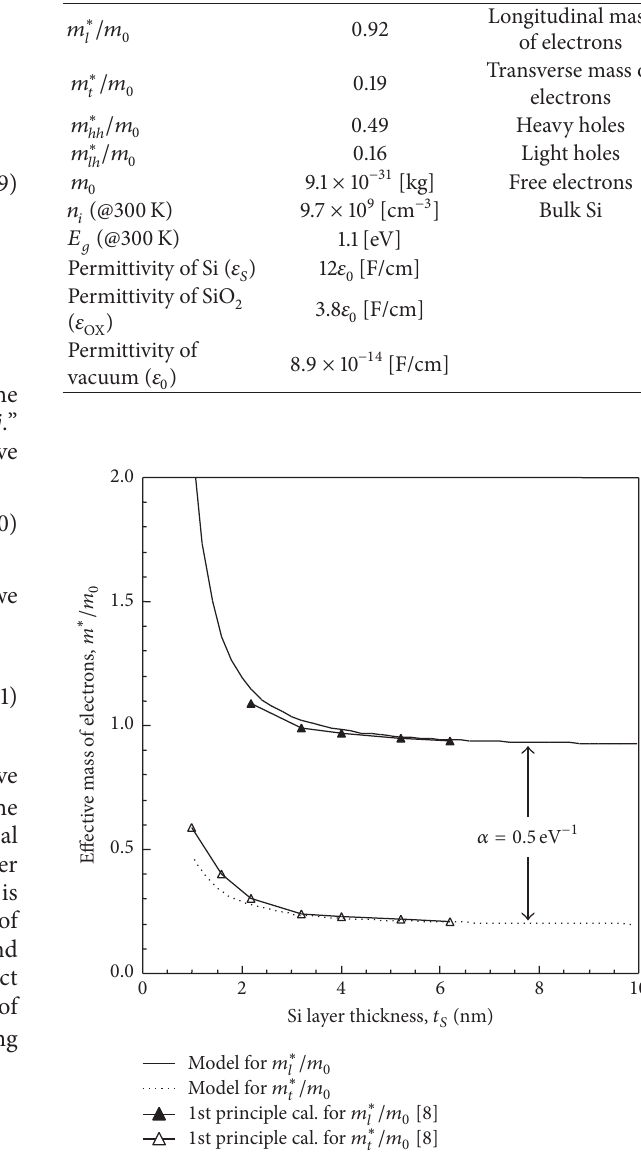
Figure1:Calculatedeffectivemassvaluesofelectronsoccupyingthe ground state as a function of semiconductor layer thickness [11]. It is assumed that 𝛼 = 0.5 eV −1 in order to calculate the nonparabolic band